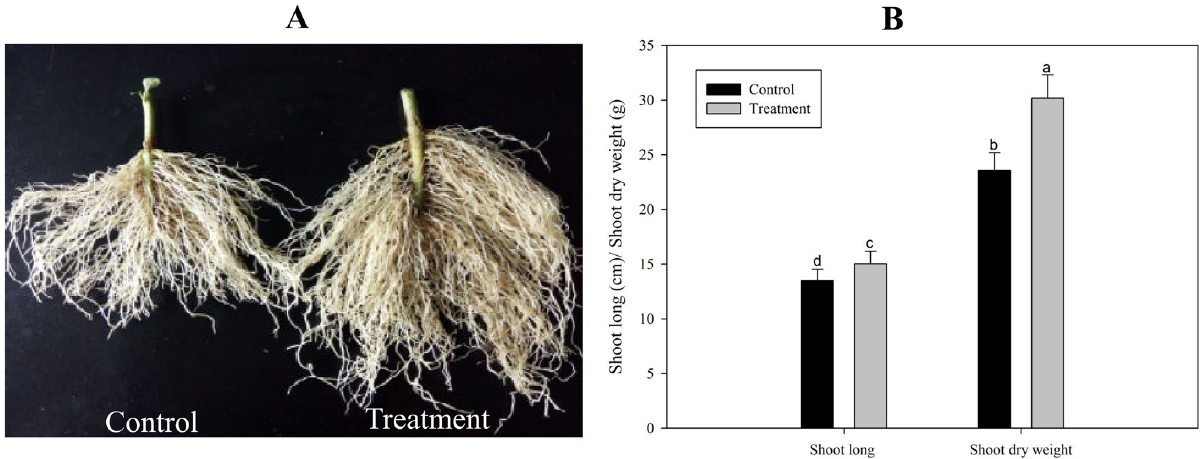
Figure 5. Effect of Chlorella extracts on the growth of pepper roots. Shoot length and shoot dry weight of the pepper plants (Control group and Treatment group) were measured on 21th day after Chlorella extracts treatment. Control: no Chlorella extracts treatment; Treatment: plants were treated by Chlorella extracts; SAS analysis at 5% is shown in lowercase letters to indicate significant differences. Vertical bars in the figures represent ± SD of five independent biological replicates.